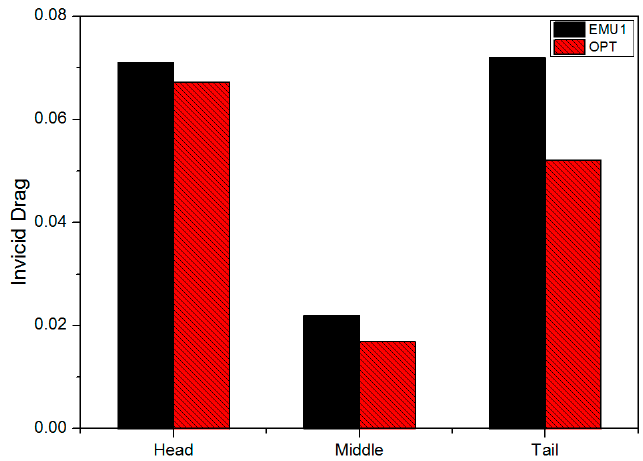
Figure 14. Comparison of drag coefficients of each carriage before and after optimization.